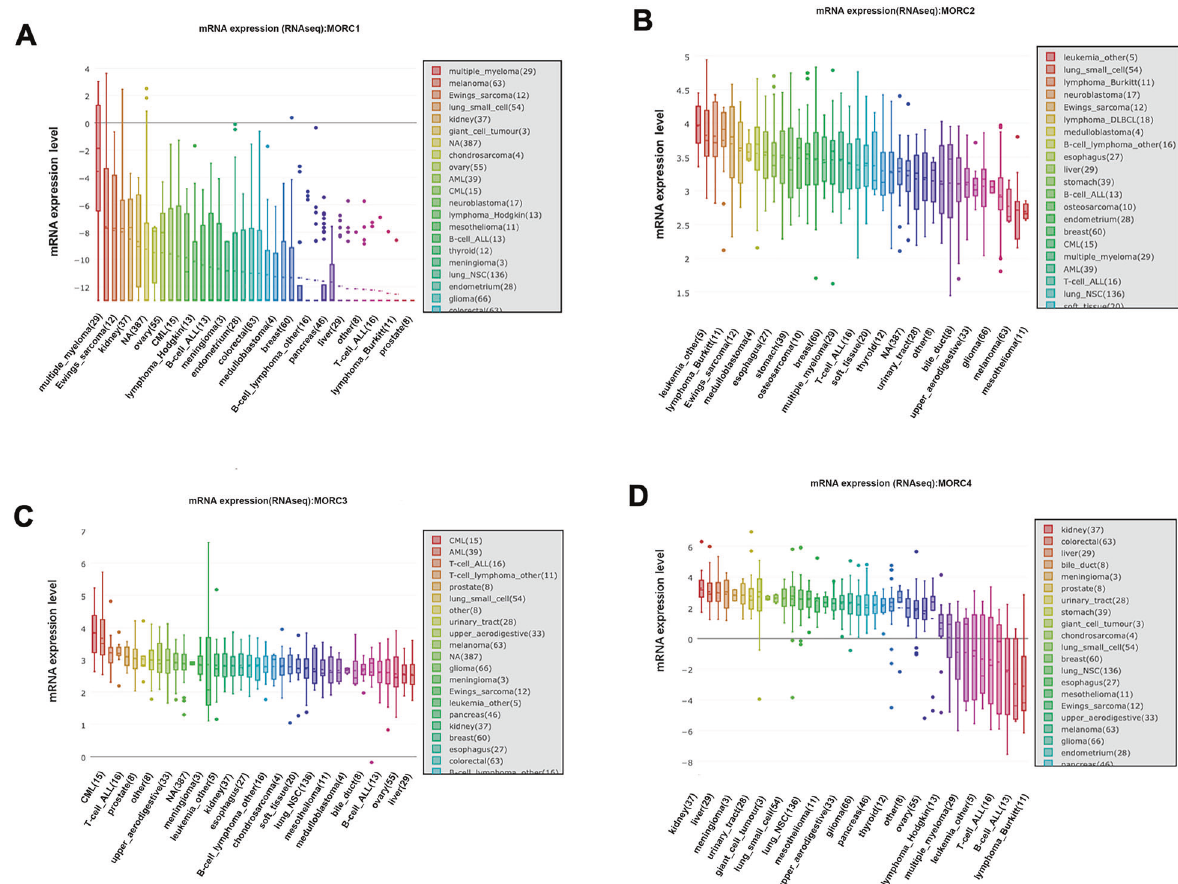
Fig. 3 The mRNA expression of MORC family in various cancer types. The CCLE database (https://portals.broadinstitute.org/ccle/home) demonstrated the diversi fi ed expression level of MORC1 ( A ), MORC2 ( B ), MORC3 ( C ), and MORC4 ( D ) with RNA sequence databases in different cancer cell lines. MORC1 to MORC4 expressed the high level in myeloma, leukemia, breast, gastrointestinal, liver and kidney cancer cell lines. All the values of mRNA expression (RNAseq) were processed by log2-fold-change. A box plot is sorted and colored by average distribution of a gene ’ s expression in a lineage. Lineages are composed of a number of cell lines from the same area or system of the body. The highest average distribution is on the left and is colored red. The dashed line within a box is the